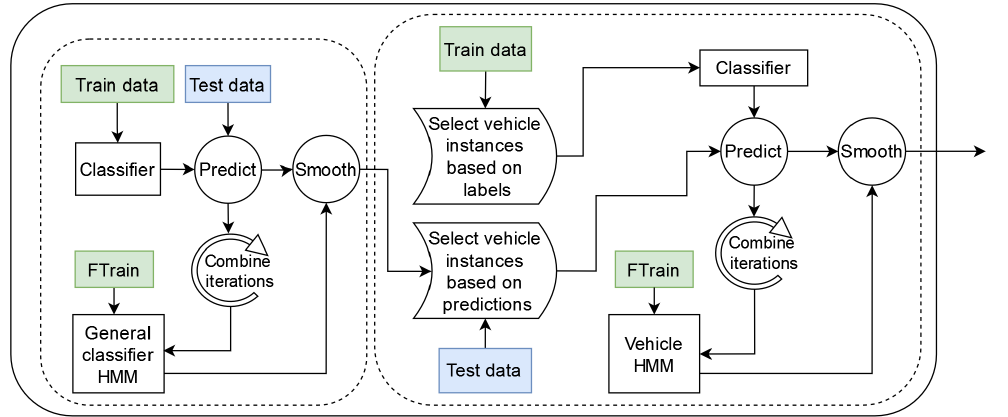
Figure 10. The pipeline used to test the usefulness of HMMs on the data from